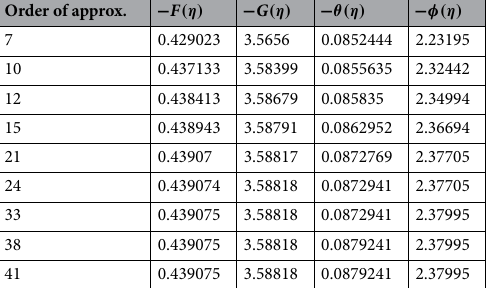
= 0.49, M = 3.3, U = 1.2, Pr = 6.7, γ 1